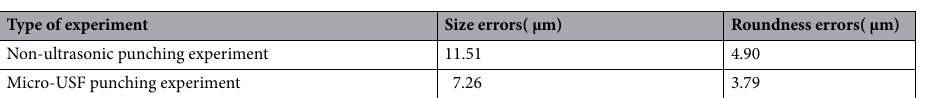
Table 6. Diameter error and roundness error of samples obtained with and without ultrasonic